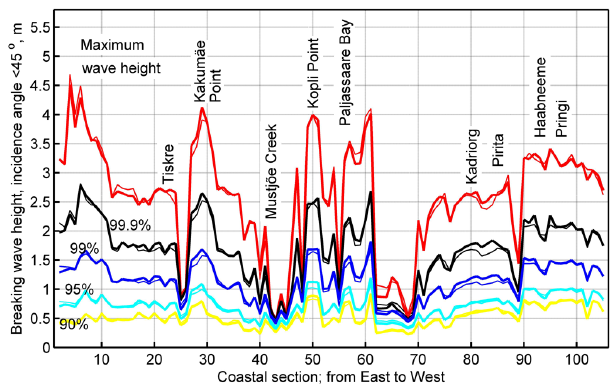
Fig. 7. Maximum wave heights, higher quantiles and median wave height for waves approaching from the direction of maximally ± 45 ◦ with respect to the normal to the coast. Thin lines indicate the mod- elled wave heights, and bold lines show values for the breaking- wave heights calculated from Eq.